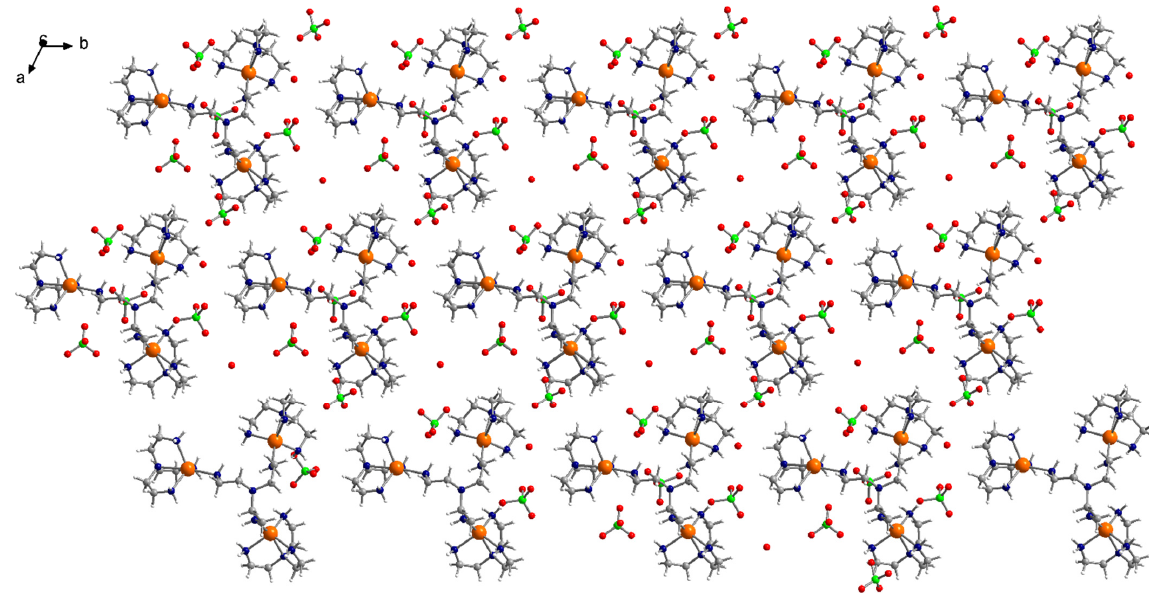
Figure 2. View along the crystallographic c axis of a packing diagram in crystal 1 . Crystals 2021 , 11 , x FOR PEER REVIEW 5 of 8 The exposure of the reaction mixture for longer time to atmospheric condition allows the partial replacement of the bridging tren ligands with carbonate anions resulted from the capture of atmospheric CO 2 . Compound 2 , [{Cd(tren)} 3 (tren)][{Cd(tren)} 3 ( µ 3 -CO 3 )](ClO 4 ) 10 , crystallizes after more than one week and its structure consists in two types of trinuclear cations, [{Cd(tren)} 3 (tren)] 6+ and [{Cd(tren)} 3 (µ 3 -CO 3 )] 4+ (Figure 3), and perchlorate anions.